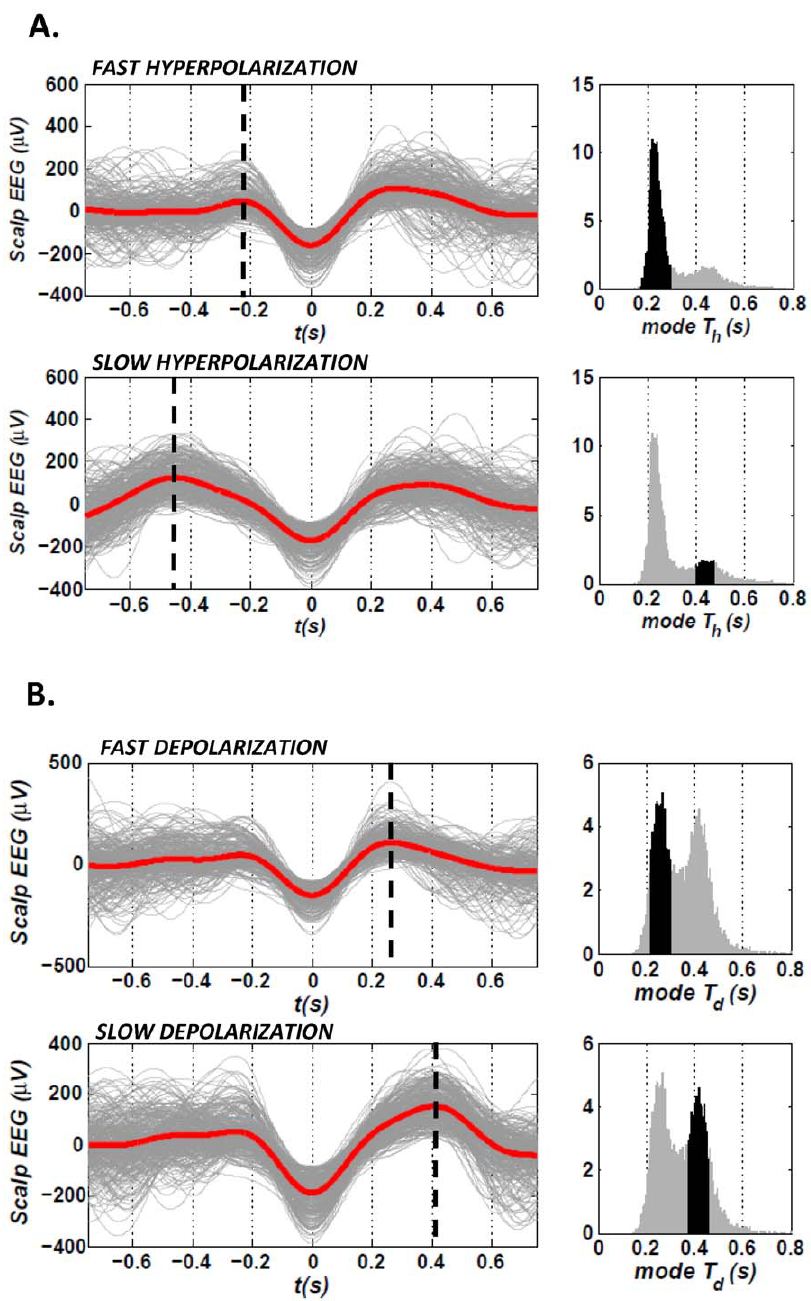
Figure 2. Examples of fast/slow hyperpolarization/depolarization slow waves. A. Superposition of filtered signals (0.1–4 Hz) of scalp EEG recordings (FP1) corresponding to 300 slow waves showing fast hyperpolarization (top) and 300 slow waves showing slow hyperpolarization (bottom) of a single subject (S1). The thick red line is the average profile of the shown filtered signals. A vertical dashed line marks the position of the hyperpolarization onset of the average signal. The graphs in the right panels indicate the region in the mode T h distribution from which the events in the figures have been drawn. B. Superposition of filtered signals (0.1–4 Hz) of scalp EEG recordings (FP1) corresponding to 300 slow waves showing fast depolarization (top) and 300 slow waves showing slow depolarization (bottom) of subject S1. The thick red line is the average profile of the shown filtered signals. The vertical dashed line marks the end of the depolarization (as has been defined in the text). The graphs in the right panels indicate the region in the mode T d distribution from which the events in the figure have been drawn.